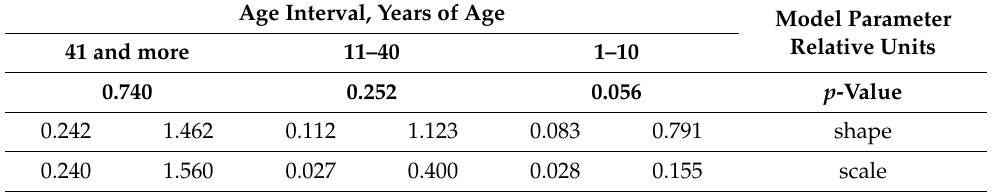
Table 1. p -values for the test of verifying the attribution of crown radius values of Siberian larch trees by age intervals to Weibull distribution, and the Weibull distribution parameters for each of the